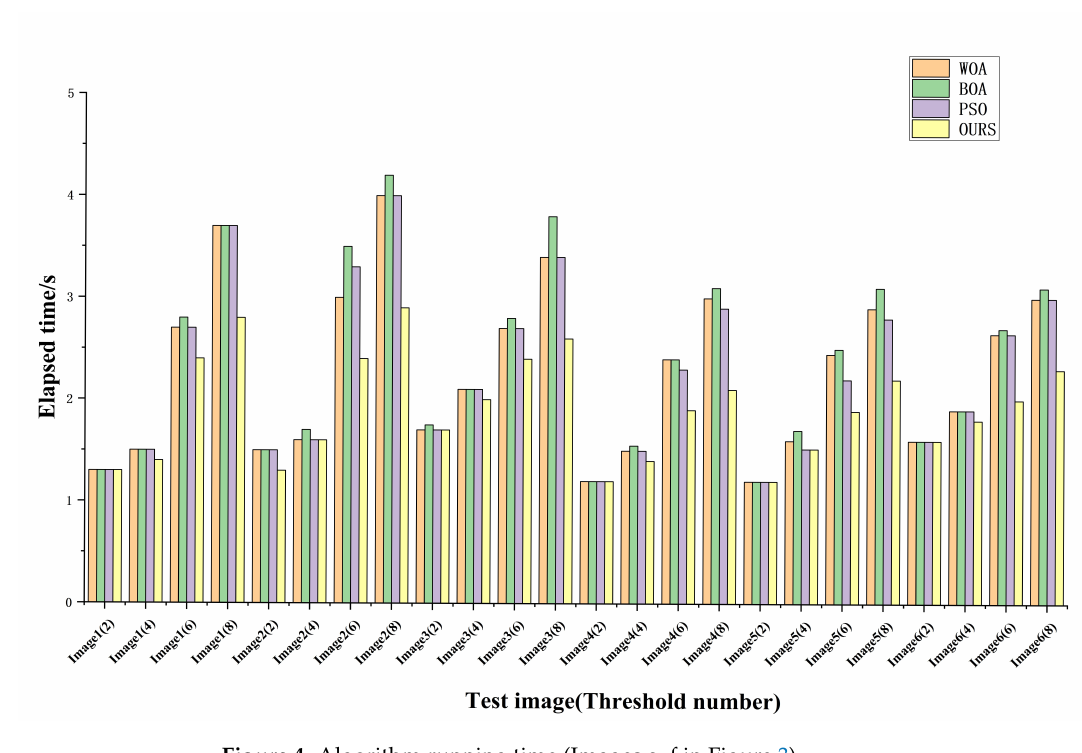
Figure 4. Algorithm running time (Images a–f in Figure 3).